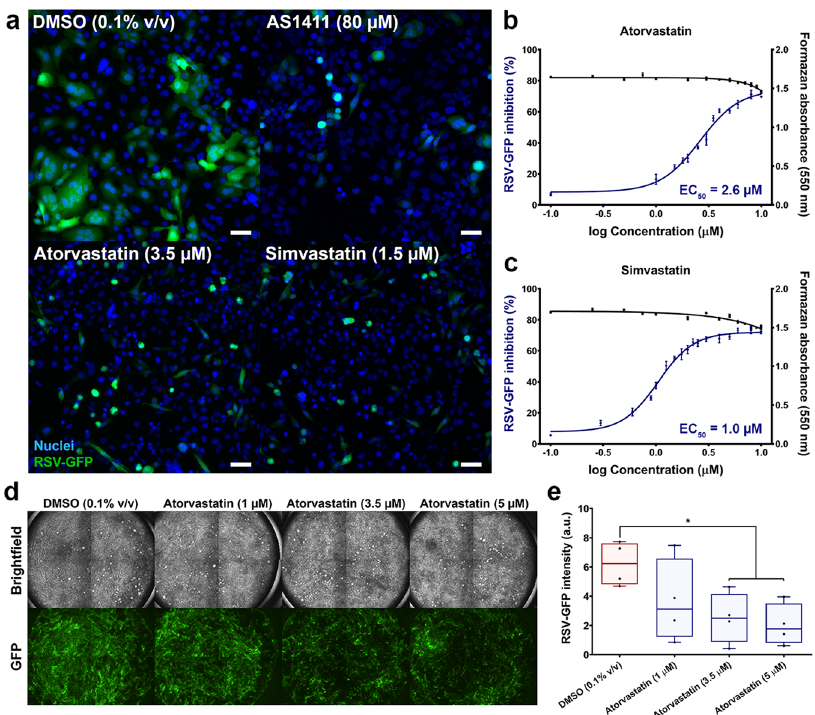
Fig. 2 Statins dose-dependently inhibit RSV infection of HEp-2 cells and well-differentiated PNECs. Live fl uorescent imaging of cells infected with RSV- GFP demonstrates viral inhibition following statin treatment, as indicated by decreased GFP fl uorescence and reduced syncytium formation. a Representative images of infected HEp-2 cells acquired 48 h p.i. Statins were added 2 h post-viral exposure. DMSO was used as a vehicle control and AS1411 was included as a positive control for inhibiting infection. Scale bars = 100 µ m. b , c Dose-dependent inhibition of RSV-GFP (MOI 0.5) by statins was observed in HEp-2 cells with effective concentrations (EC 50 ) of 2.6 and 1.0 µ M for atorvastatin and simvastatin, respectively (curves shown in blue). No signi fi cant changes to cellular viability were observed from baseline at EC 50 for each drug, as quanti fi ed by MTT assay (curves shown in black). Values are reported as means ± SEM ( n = 3 independent measurements). d Human PNECs cultured on an air – liquid interface develop a ciliated phenotype which models the in vivo respiratory epithelium. Shown are representative images of well-differentiated PNECs acquired 72 h after apical surface infection with RSV-GFP (MOI 0.01). Atorvastatin was added to the basal medium at each speci fi ed concentration 2 h post-viral exposure. e Atorvastatin dose- dependently reduces RSV-GFP infection of WD-PNECs, with signi fi cant reductions observed at 3.5 and 5 µ M ( n = 4 PNEC donors). Box plots indicate the complete range (whiskers), interquartile range (box), and median (line) of measurements (a.u. arbitrary units). Statistics were calculated by a one-way ANOVA with a Dunnett ’ s multiple comparisons post hoc test (* P <